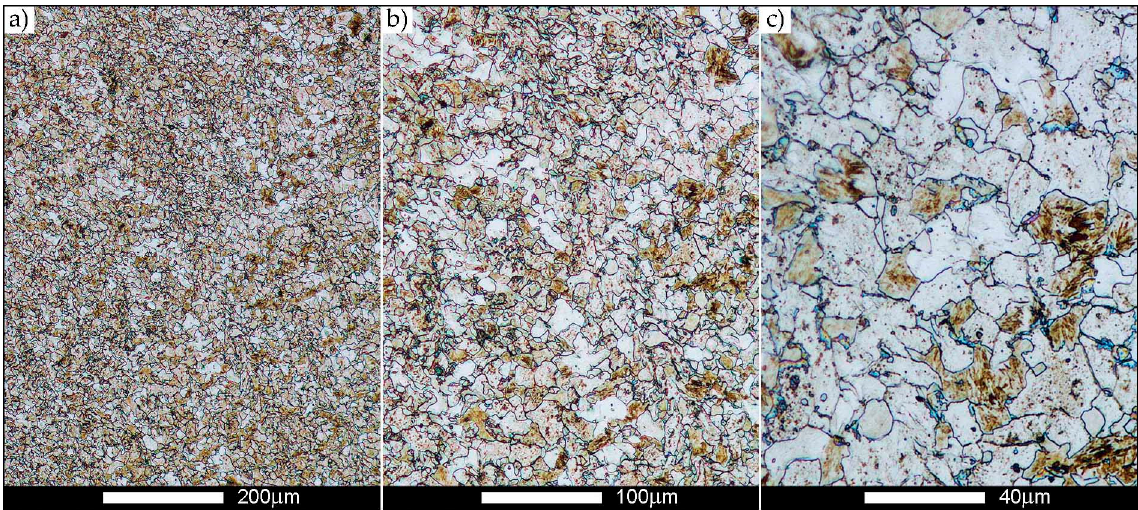
Figure 46. Welded joint microstructure of Hardox 450 steel with visible prior austenite grain boundaries, austenitised at 1000 °C—WM3 zone shown in Figure 2. ( a ) 100×; ( b ) 200×; ( c ) 500×.